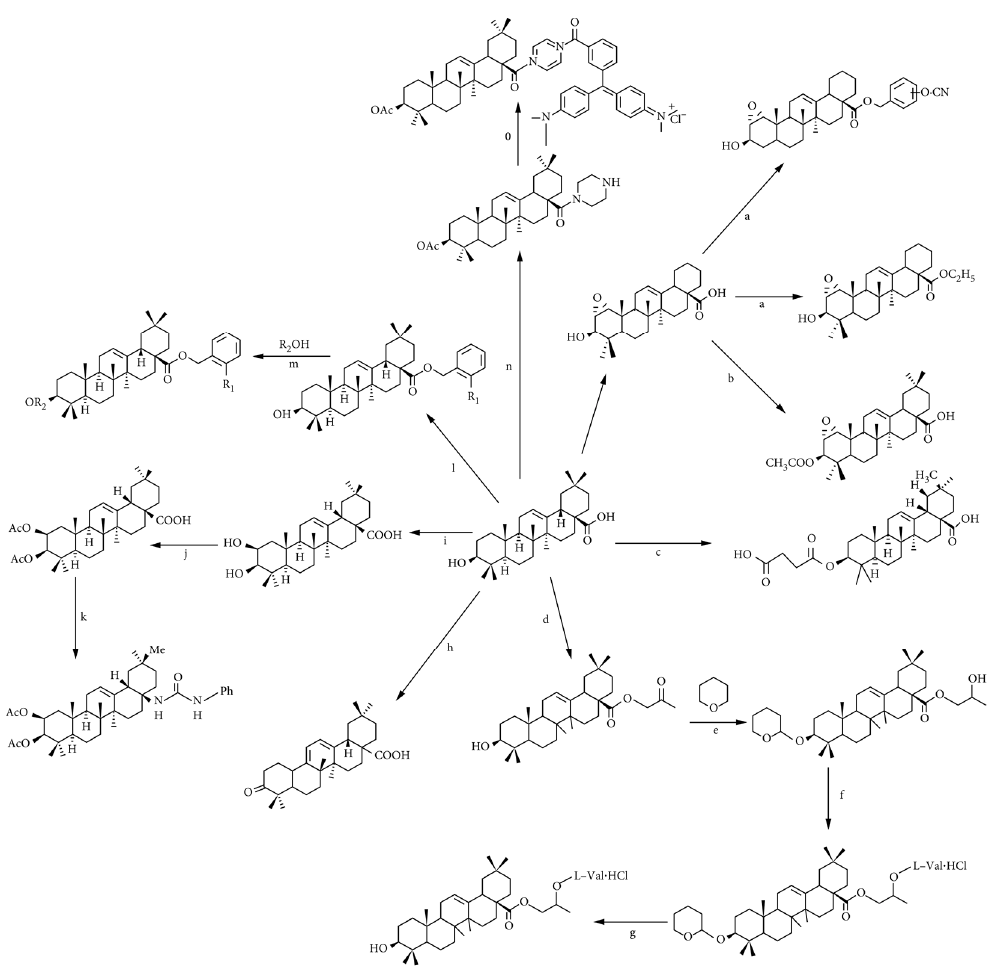
Figure 3. Synthesis of derivatives of oleanolic acid [128].